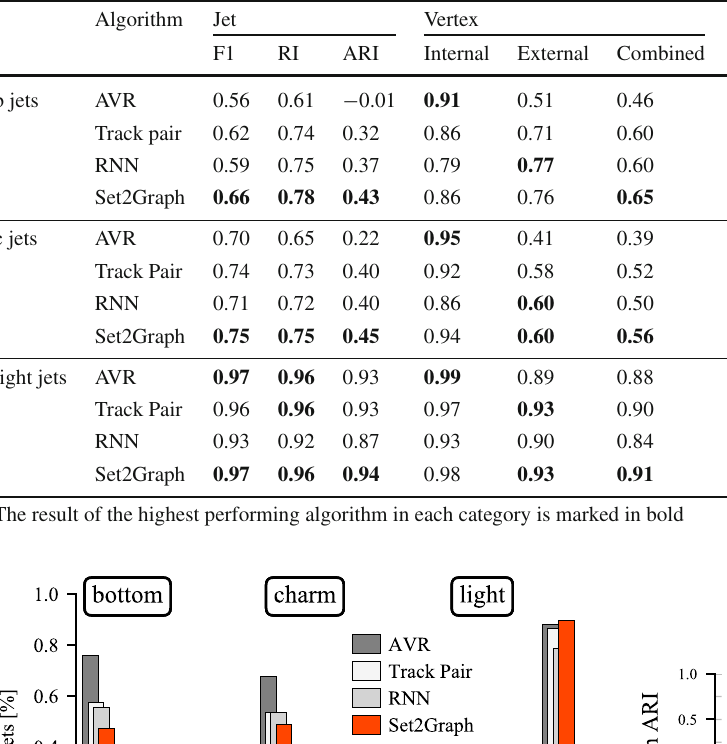
Table 2 Comparing vertex finding performance from three perspec- tives: jet, vertex and vertex-pair. See Sect. 4 for the definitions of the various metrics. The mean for each metric, split by jet flavor, is shown